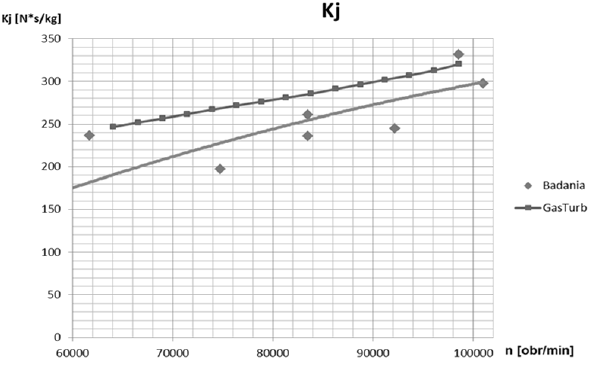
Fig. 6. Specific thrust as a function of engine rotational